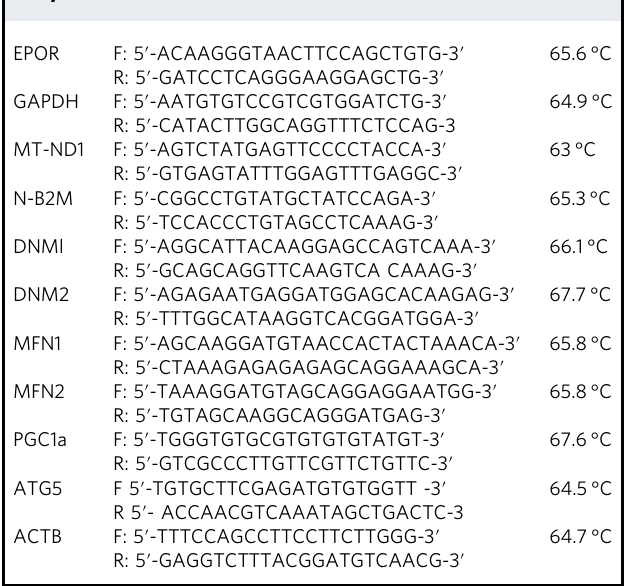
Table 1 Primers used for RT-qPCR and annealing